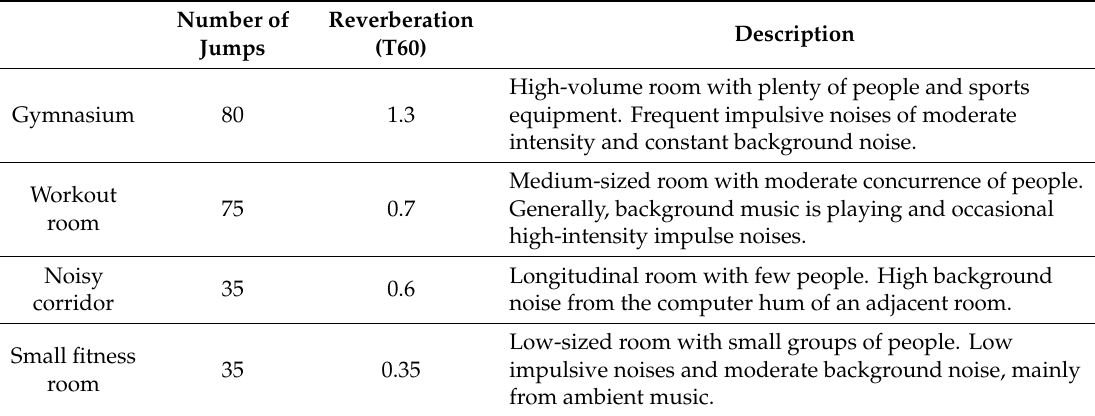
Table 1. Description of recording